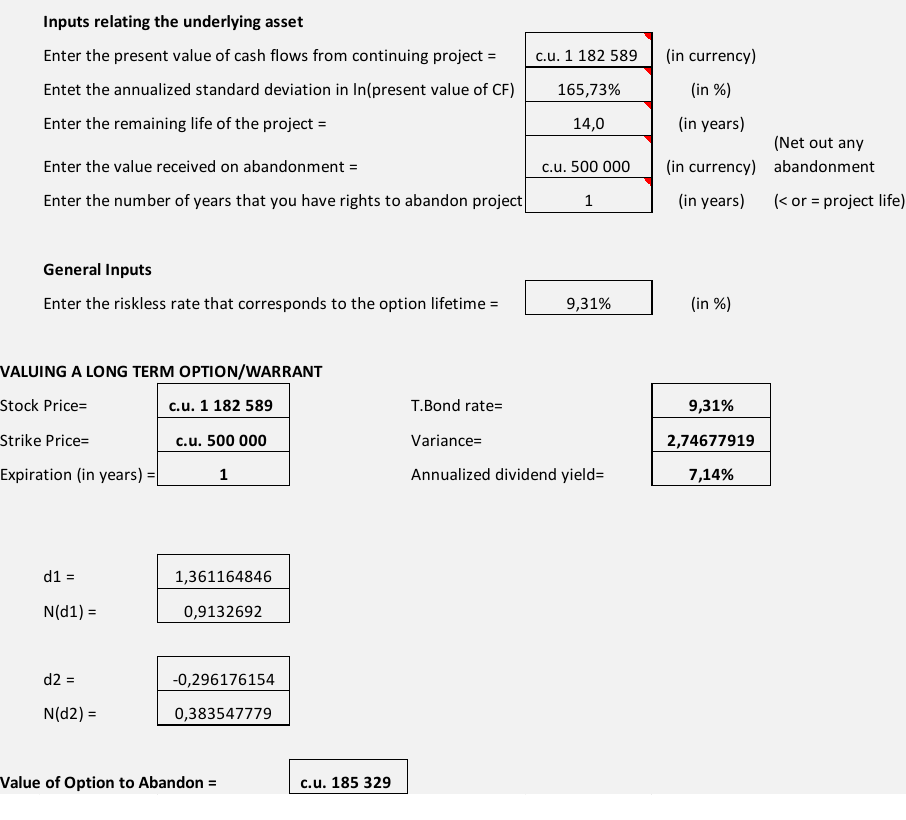
Figure 2. Calculation of the option to abandon an innovative project based on the Black-Scholes model and the option parity principle (forecast value of the spot price).